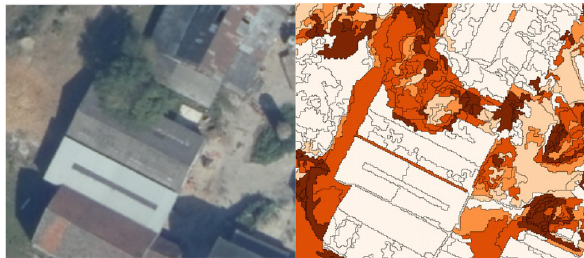
Figure 5: Illustration of uncertainty linked to object type in OBIA (darker color = higher uncertainty)